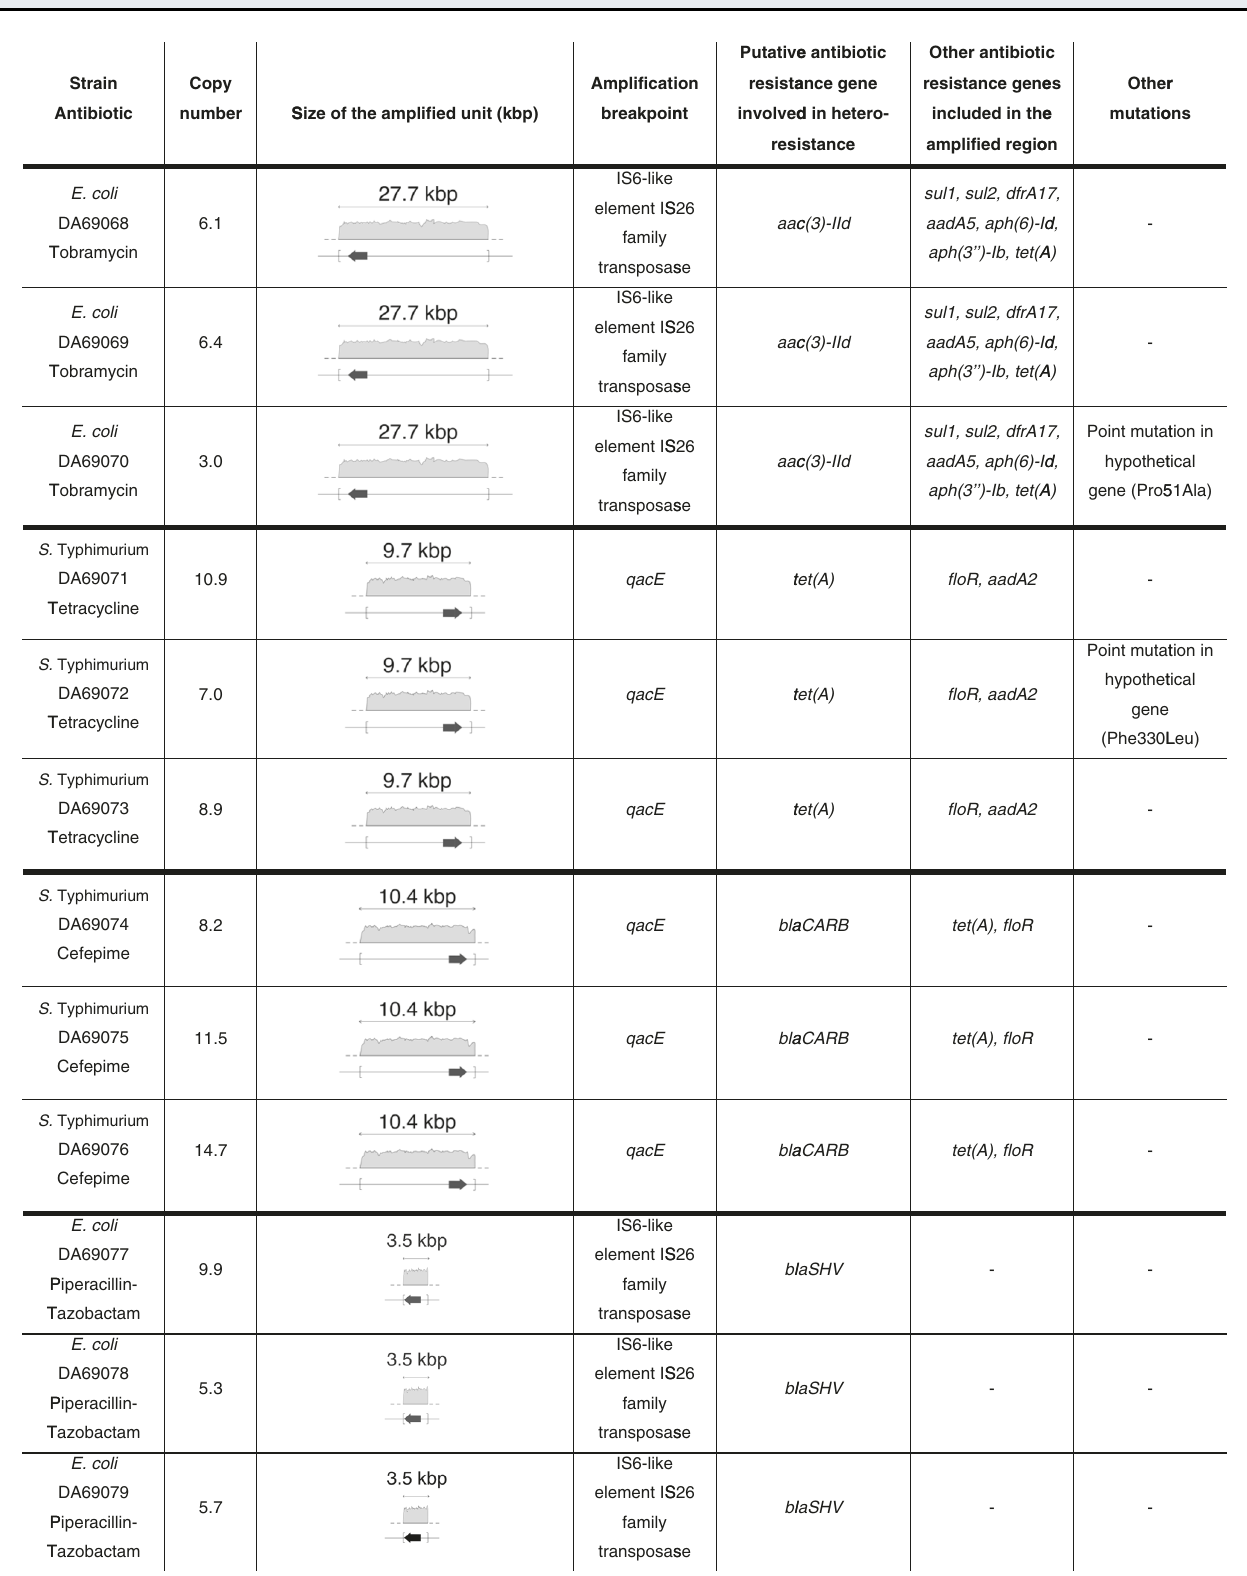
Table 2 DNA ampli fi cations of independent clones with different copy